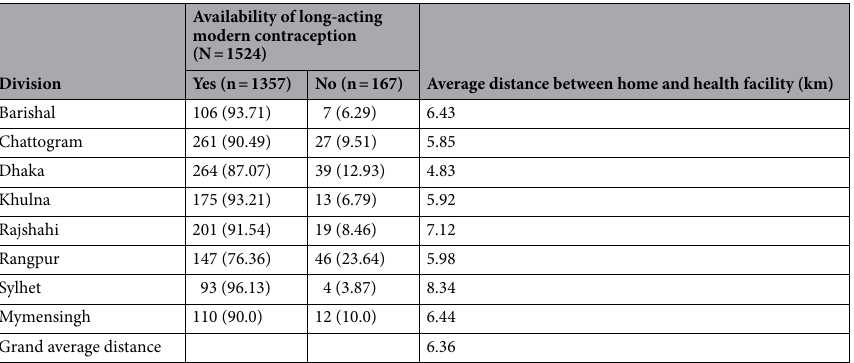
Availability of long-acting modern contraception (N =